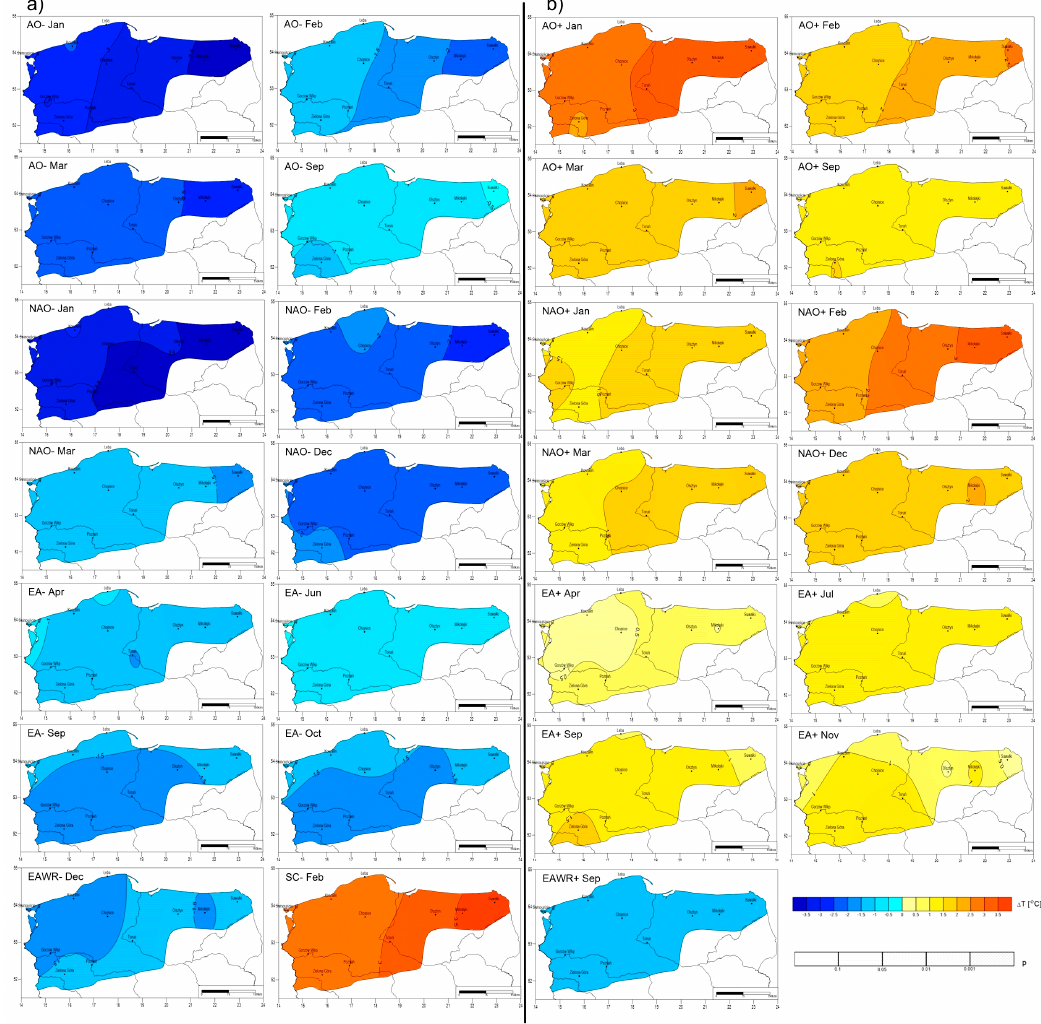
Figure 2. Spatial distribution of differences ( Δ T) in air temperature in comparison to mean values in different phases of macroscale types of atmospheric circulation and significance ( p ); ( a ) negative phase; and ( b ) positive phase.